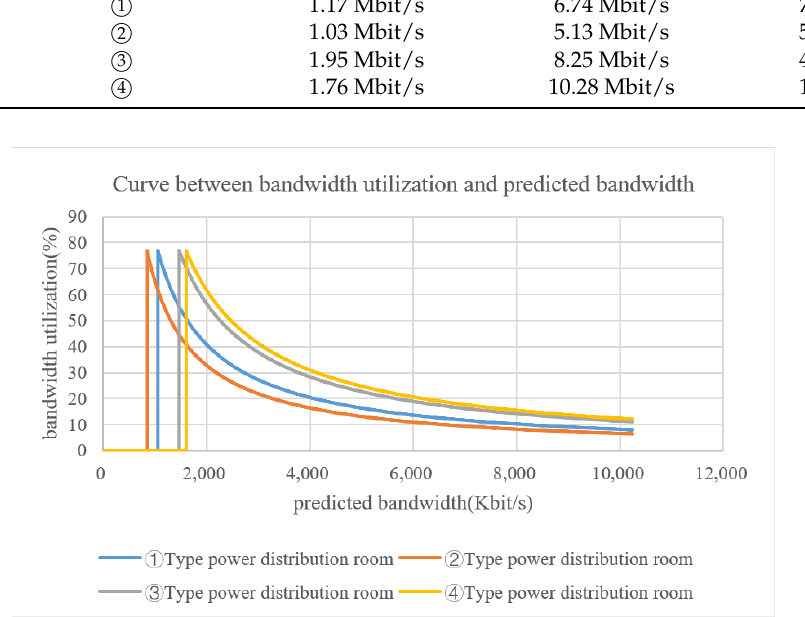
Figure 7. Curve between bandwidth utilization and predicted bandwidth.